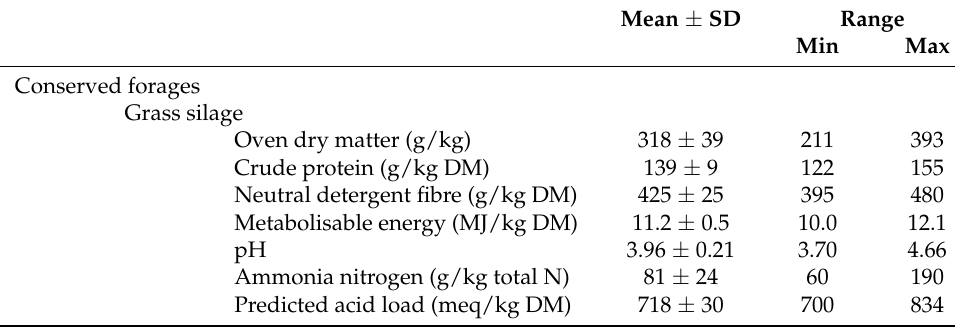
Table 1. Chemical composition of conserved forages and concentrates offered (mean, minimum and maximum) to cows throughout the study period (based on samples collected at each farm visit).